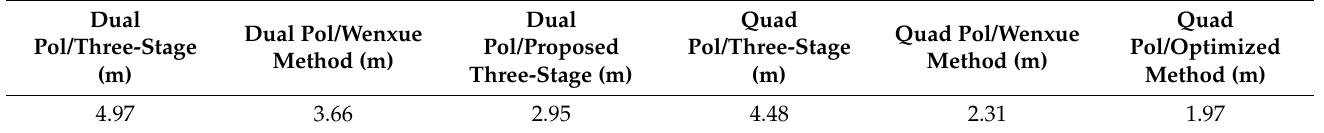
Table 2. RMSE in meters of the forest height estimation for the dual and quad PolInSAR data using conventional, Wenxue, and ESPO methods.